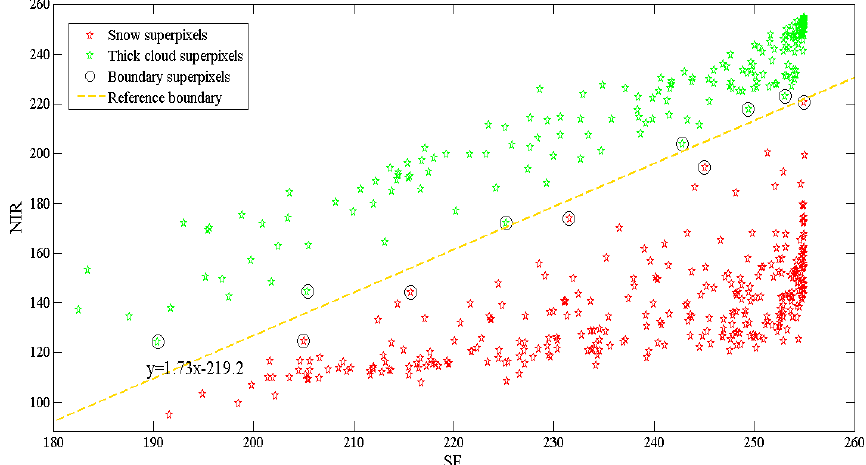
Figure 10. The features distribution of snow and thick clouds. Each pentagram represents a superpixel, plotted by the SF value on the horizontal axis and the NIR value on the vertical. The red pentagrams denote snow superpixels and the green ones are thick cloud superpixels. The circles are the boundary superpixels, and the yellow dotted line denotes the reference boundary fitted by the Least Squares algorithm.